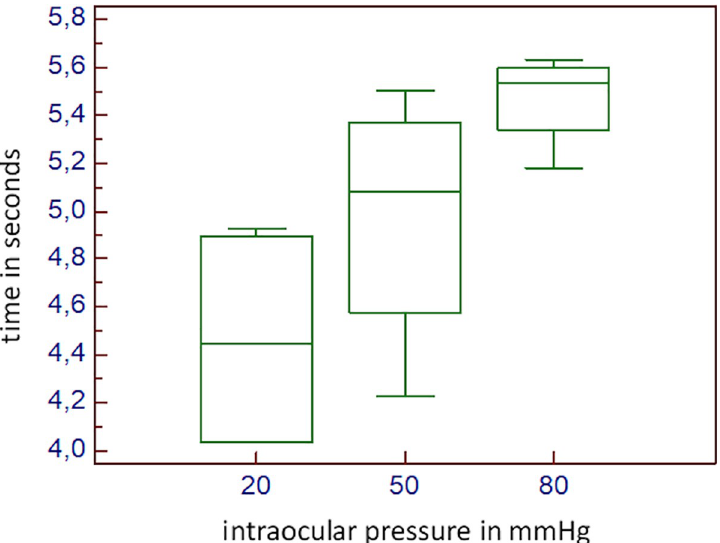
Fig 3. Boxplot of the injection time. The X-axis shows the three groups (20,50 and 80 mmHg) and the Y-axis shows the injection time in seconds [s]. Within the boxplot the median value is represented by the horizontal dividing line, and the top and bottom of the box represent the upper and lower quartile, with the whiskers indicating the maximum and minimum points.